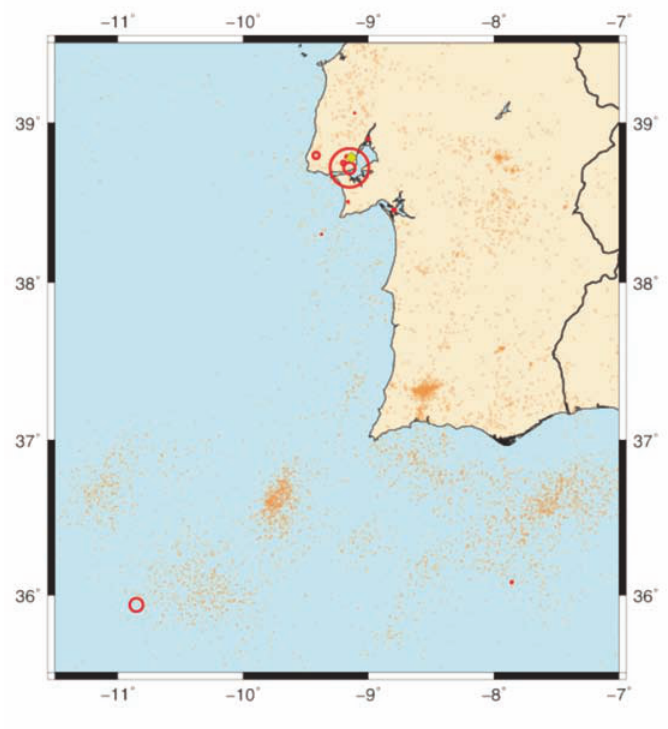
Figure 2. Map of Portugal showing the seismicity (small orange circles) of the south of Portugal for the period from January 1, 1961 to December 31, 2010 (data provided by Portuguese Meteorological Institute, Portugal). The red circles are proportional to S and highlight the most relevant